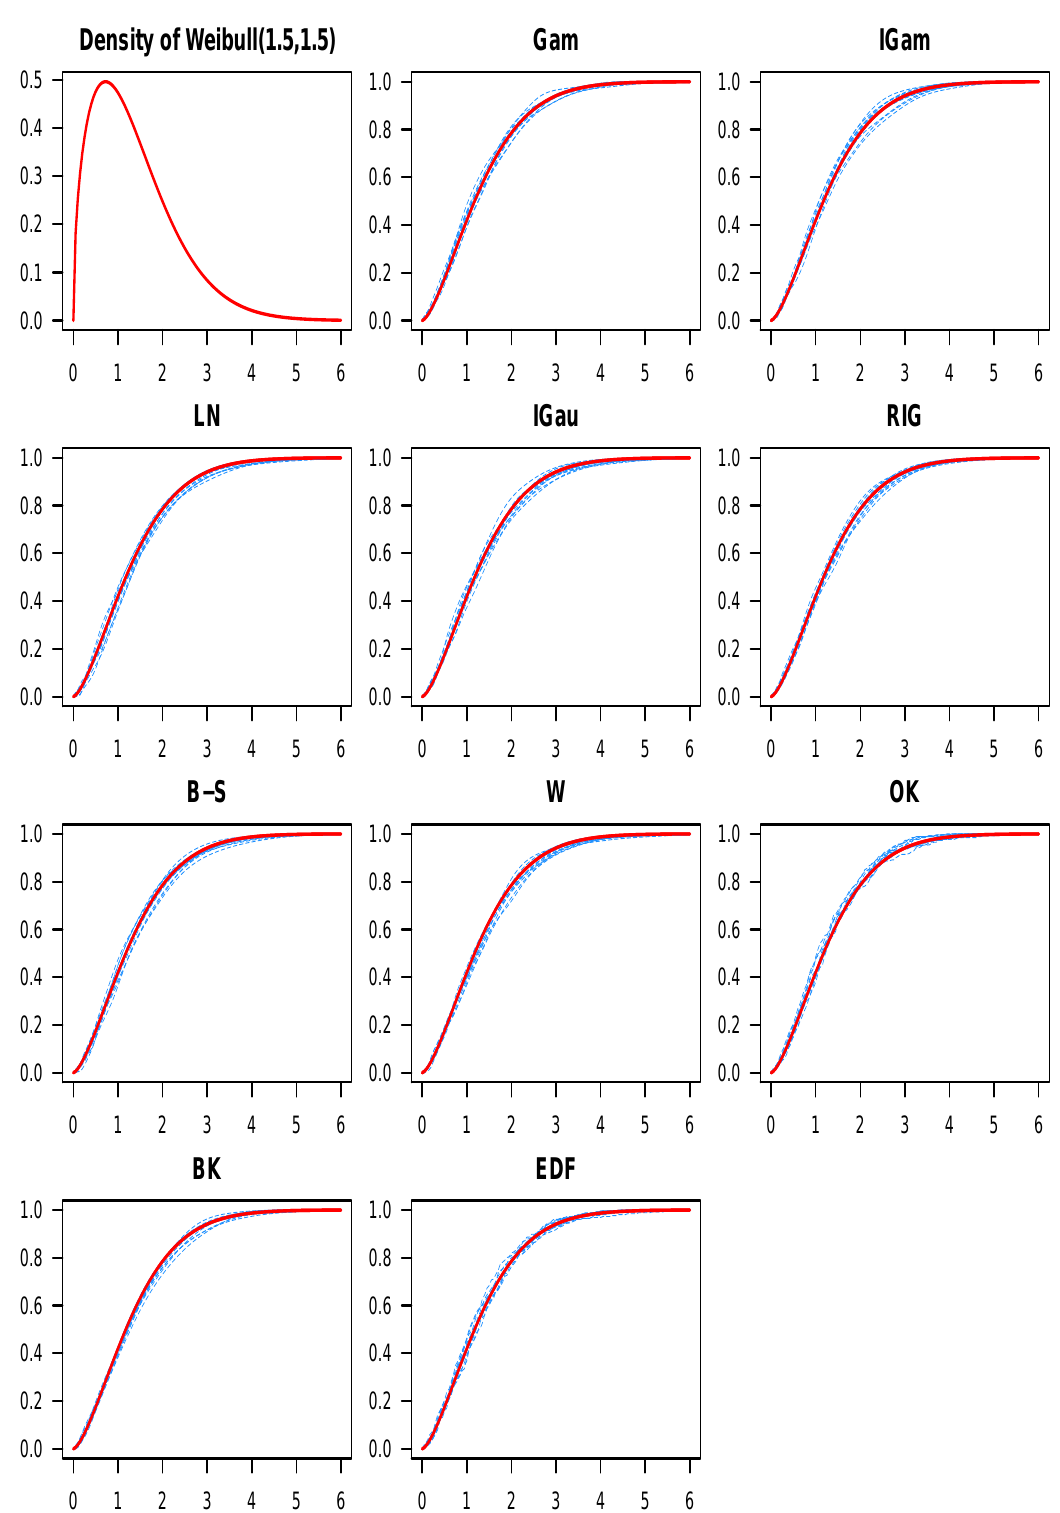
Figure 8. The Weibull ( 1.5,1.5 ) density function appears on the top-left, and the target c.d.f. is depicted in red everywhere else. Each plot has ten estimates in blue for the Weibull ( 1.5,1.5 ) c.d.f. using one of the ten estimators (the name of the corresponding kernel is indicated above each graph) and n =